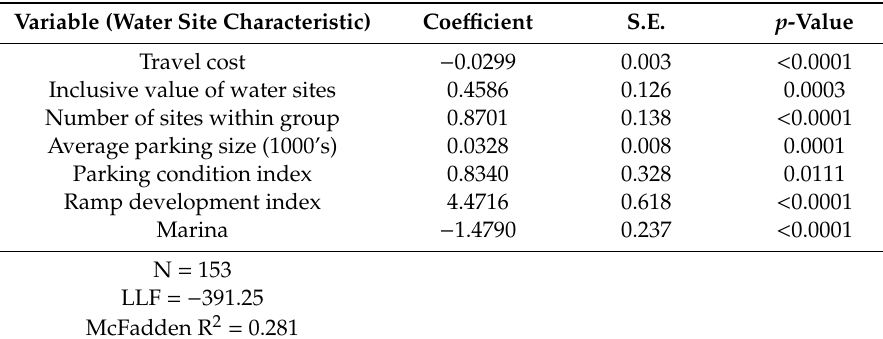
Table 2. Random utility model estimates for choice of ramp